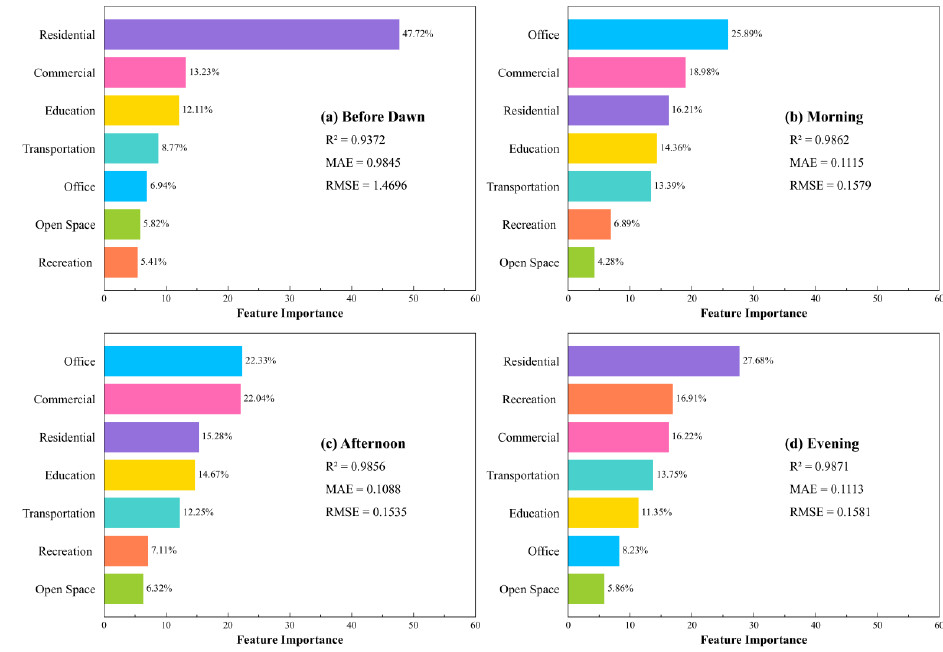
Figure 8. Results of random forest model fitting accuracy and feature importance assessment.